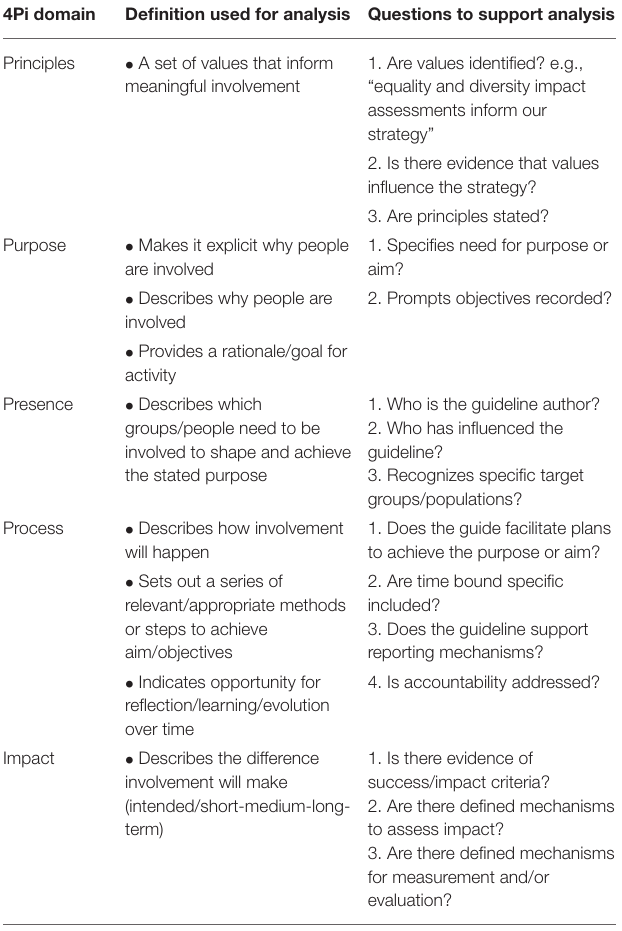
TABLE 1 | Analysis framework based on 4Pi National Involvement Standards. TABLE 2 | Breakdown of groups attending a co-design workshop aimed developing guidance for PPI in psychedelic